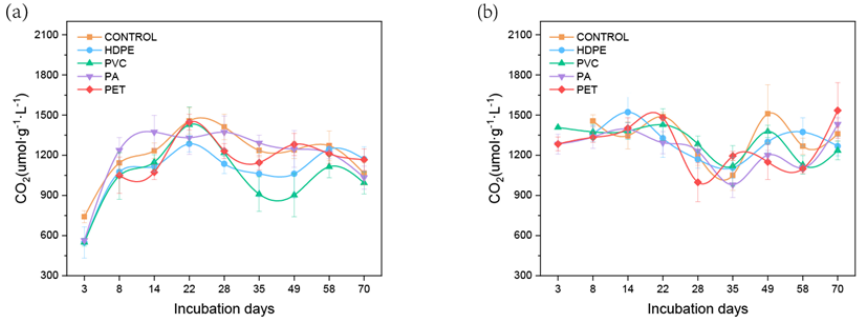
Figure 3. CO 2 concentration in saltwater ecosystem after microplastics (HDPE, PVC, PA, PET) were added. ( a ) Salt marsh ( b ) mangrove forest. added. ( a ) Salt marsh ( b ) mangrove forest.